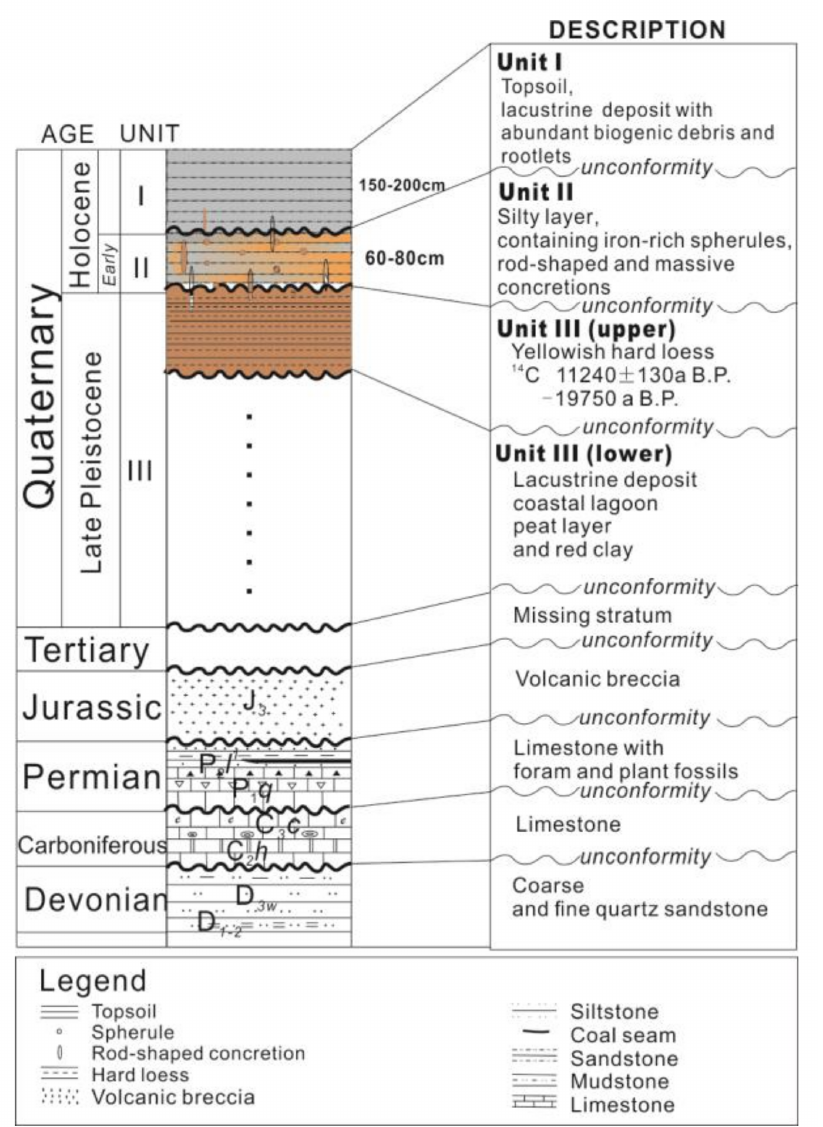
Figure 2. Composite columnar section of the vicinity of Taihu Lake area. Unit II is the specific silty layer containing abundant iron-rich concretions, including spherules, rod-shaped concretions and irregular-shaped massive